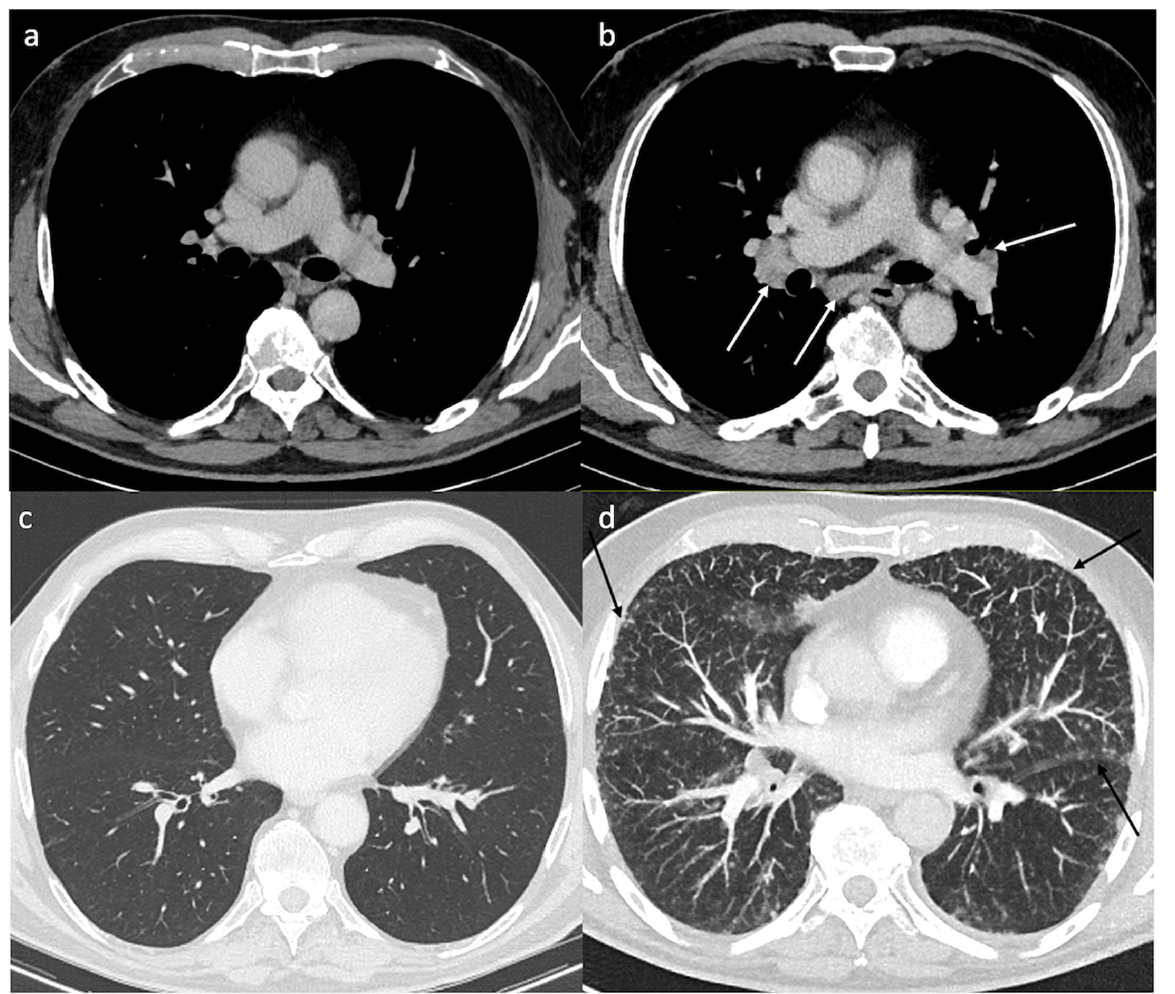
Figure 3. Typical findings of pulmonary sarcoidosis. Axial contrast enhanced computed tomography (CT) shows no mediastinal lymph node enlargement ( a ) and no parenchymal disease ( c ) before treat- ment. Five months after immunotherapy, axial enhanced CT shows typical bilateral and symmetric hilar and subcarinal lymph nodes ( b ) and multiple micronodules with a perilymphatic distribution (subpleural and perifissural nodules) (black arrows- d